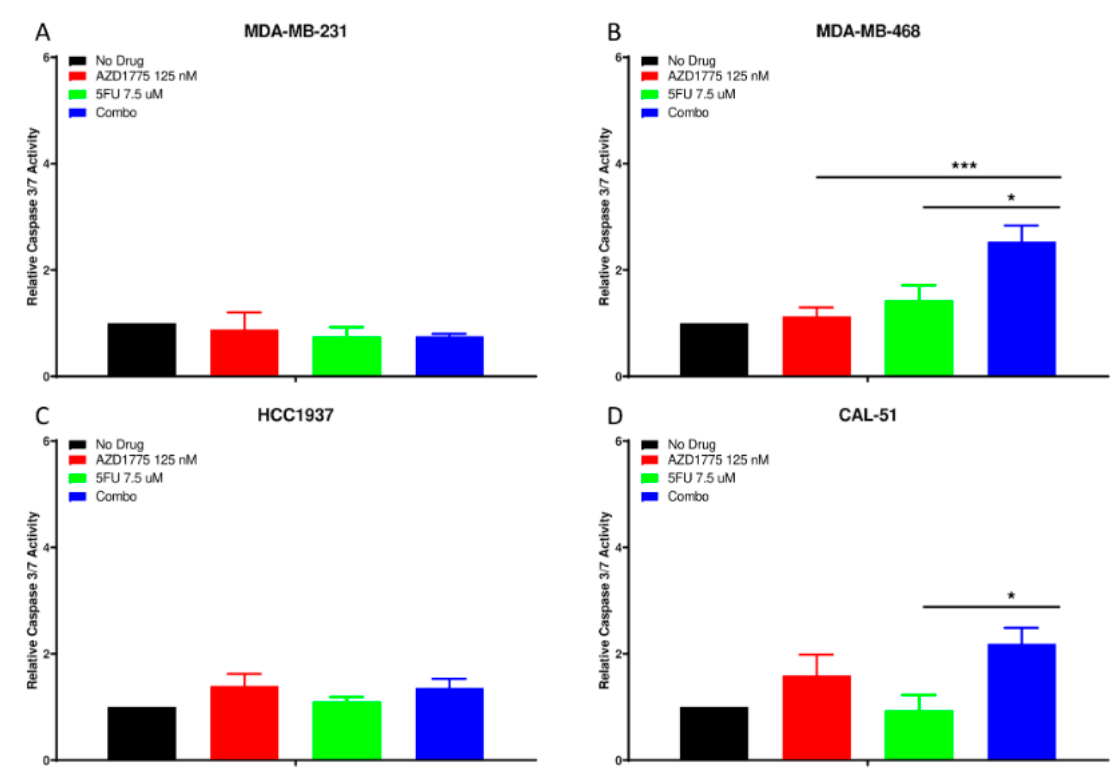
Figure 5. Apoptotic effects of AZD1775 and 5FU in TNBC cell lines. Cells were treated with AZD1775 and 5FU and caspase 3/7 activity was assessed at 24 h using Caspase Glo 3/7 assay. ( A ) MDA-MB-231, ( B ) MDA-MB-468, ( C ) HCC1937, and ( D ) CAL-51. A t-test was performed to compare the combination treated to each of the single agent (* = p ≤ 0.05; *** = p ≤ 0.001).